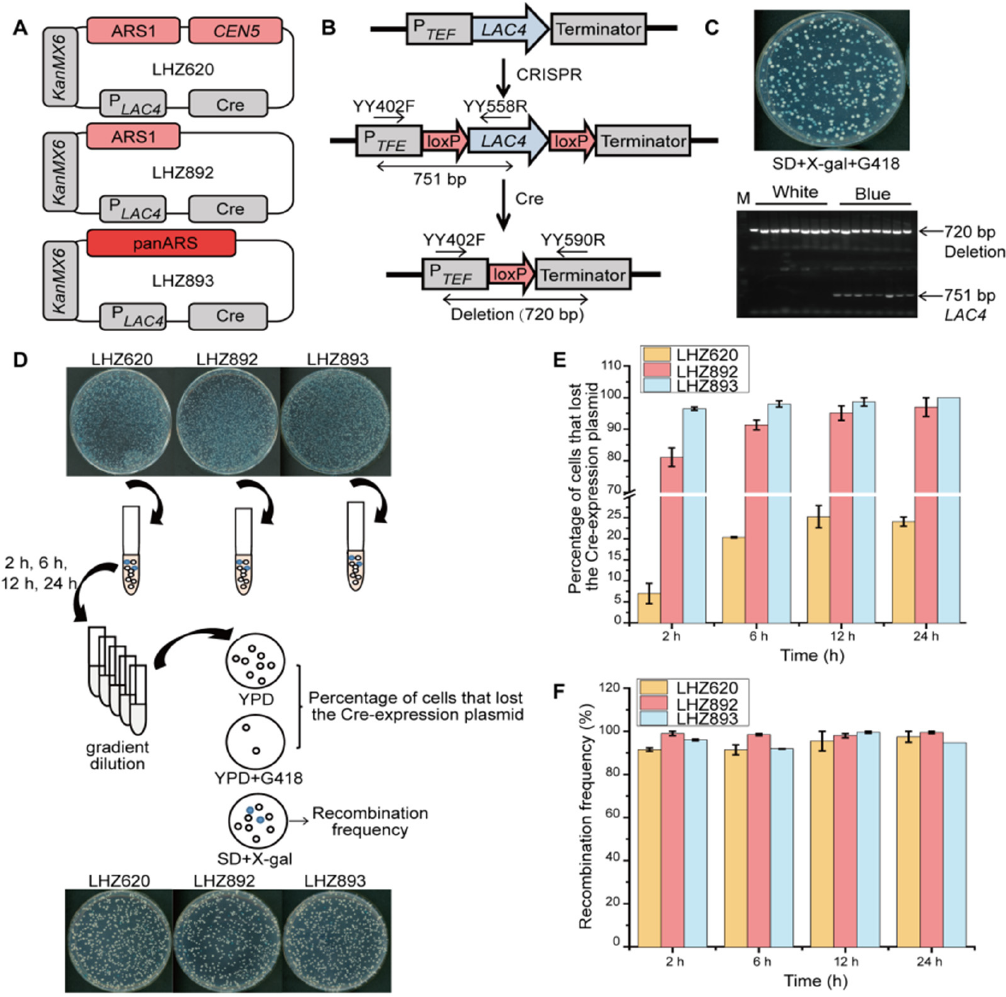
Figure 2. Establishment of a Cre-loxP system controlled by a LAC4 promoter and panARS element in K. marxianus . ( A ) A schematic representation of three Cre-expressing plasmids. ( B ) A schematic representation of the deletion of the LAC4 gene by the Cre-loxP system. ( C ) Identification of the deletion of the LAC4 gene by colony PCR. A representative plate of LHP719 transformed with LHZ620 is shown above. White and blue colonies were subjected to colony PCR using YY402F/YY558R and YY402F/YY590R primer pairs. ( D ) The flow chart to measure the percentage of cells that lost the Cre plasmid and frequency of recombination after growing in unselective YPD medium. ( E , F ) The percentage of cells that lost the Cre plasmid ( E ) and the frequency of recombination at the LAC4 locus ( F ) after growing in YPD for indicated times. The value represents mean ± standard errors (n =